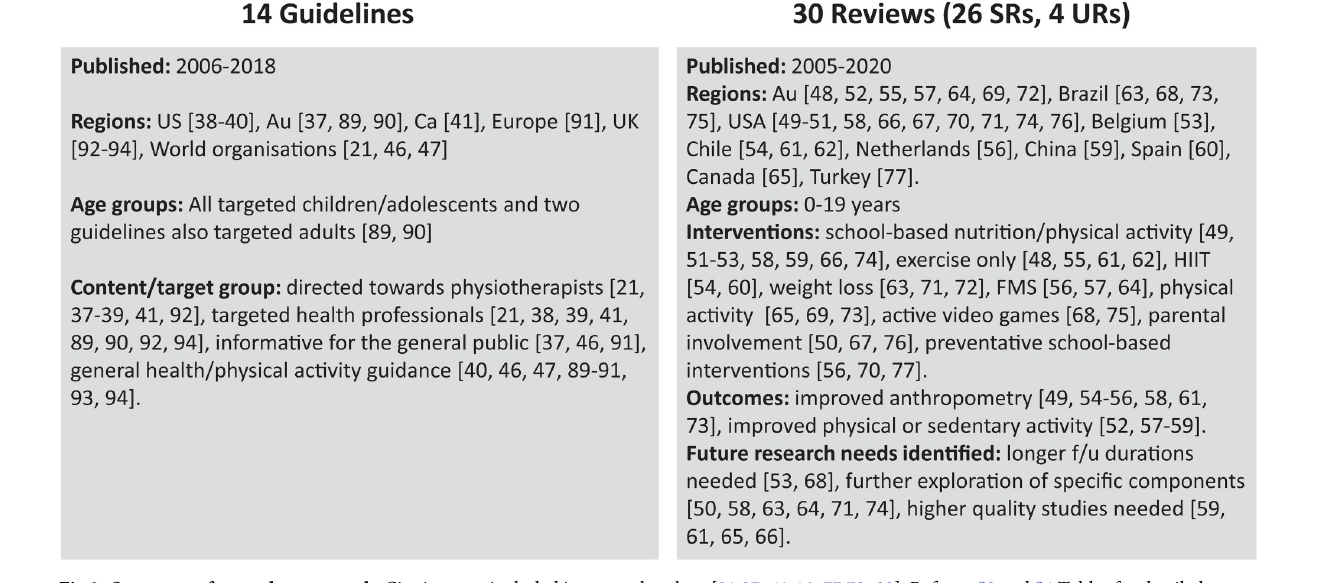
Fig 2. Summary of secondary research. Citations are included in square brackets [21,37–41,46–77,78–83]. Refer to S3 and S4 Tables for detailed information for Guidelines and Reviews respectively. Abbreviations: Au—Australia, Ca—Canada, SRs—systematic reviews, UK—United Kingdom, URs—Umbrella reviews, US—United